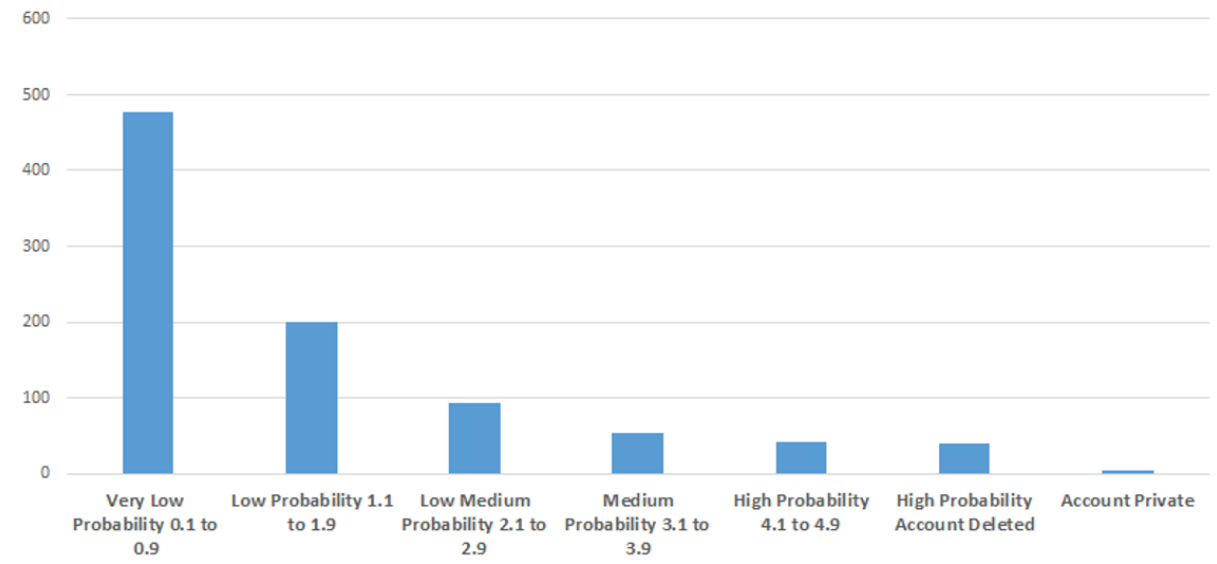
Figure 2. Assessing the number of bots on a scale from 0 to 5 using Botometer.